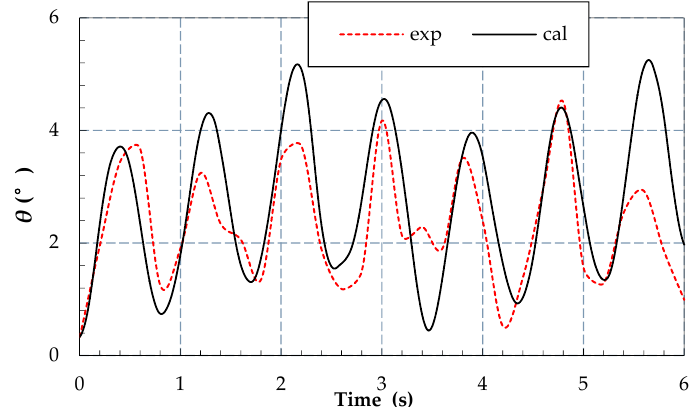
Figure 23. Cycle oscillation pitch contrast curves for the operation condition of λ = 7 m, F n = 0.99.